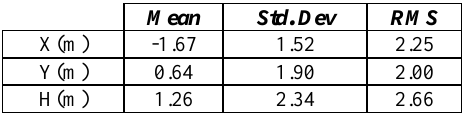
Table 2. Results of the accuracy test over the Check Points